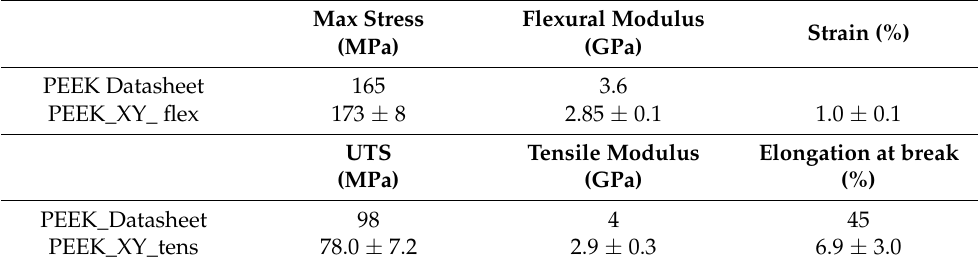
Table 7. Main results of mechanical characterization.